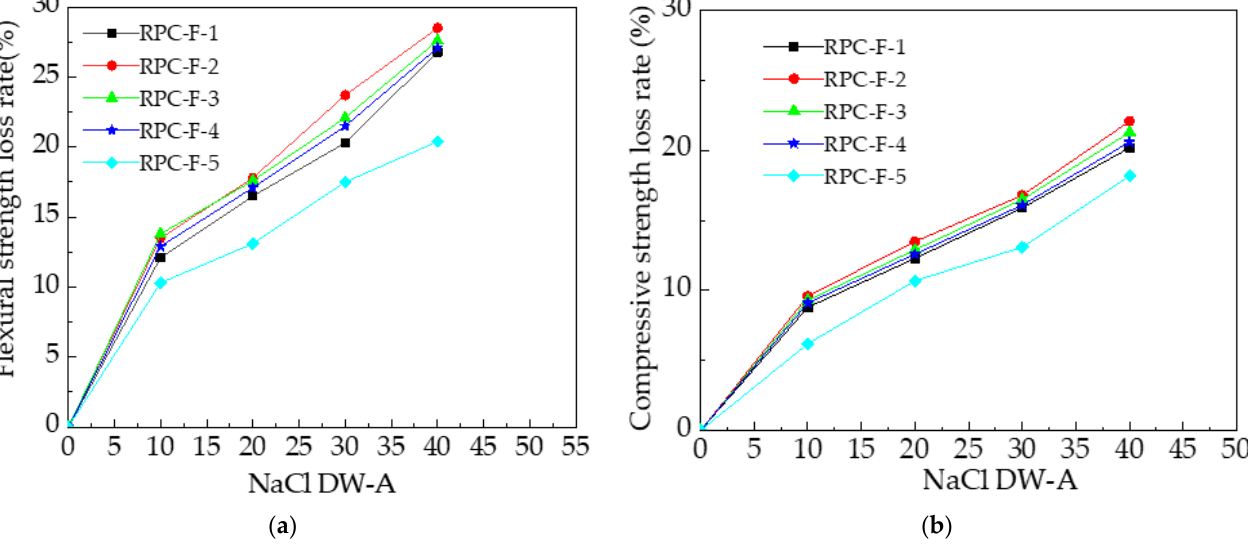
Figure 11. Mechanical strength loss rates after NaCl DW-A. ( a ) Flexural strength loss rate ( b ) Com- pressive strength loss rate.